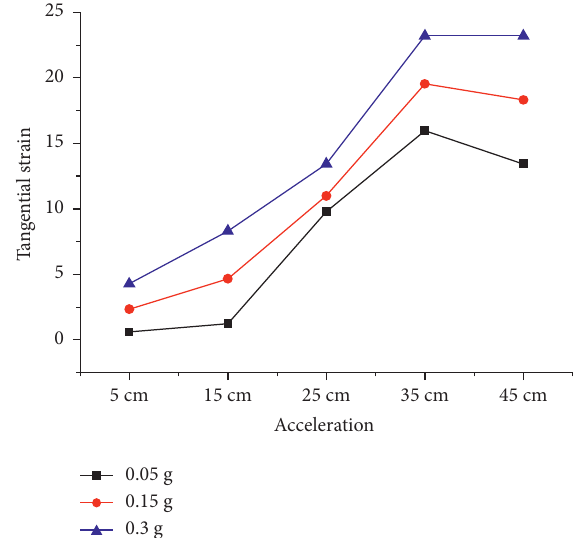
Figure 17: Longitudinal strain curve of vault exterior (13Hz).